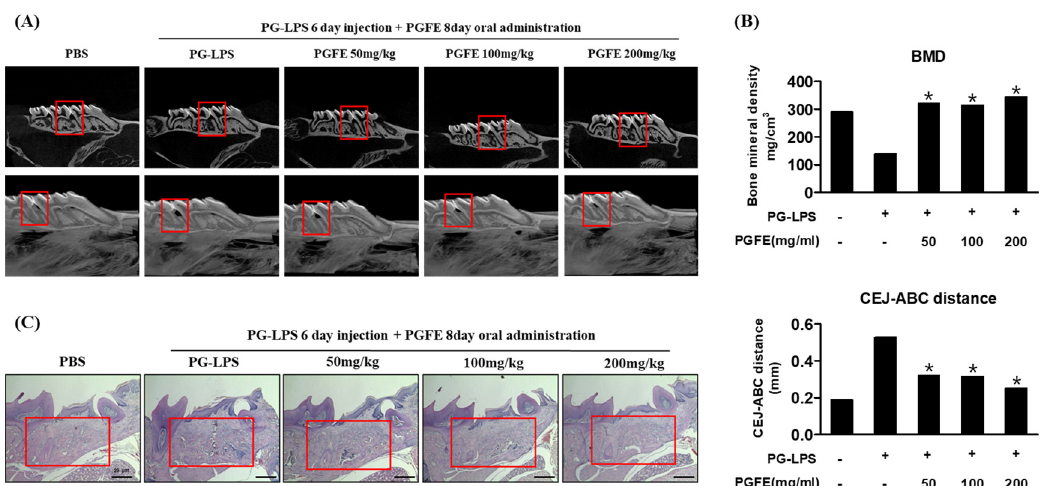
Figure 9. Inhibitory effect of PGFE on periodontitis in PG-LPS-induced in vivo model. ( A ) Micro-CT analysis of newly formed bone by PGFE, the red mark is the PG-LPS injection area. ( B ) Quantification of distance between CEJ and ABC, and bone mineral density. Analysis tables were determined using CTAn software. ( C ) Histological analysis of the periodontium using H&E staining. * p < 0.05 vs. only PG-LPS treated group. Scale bars denoted 20 µm.